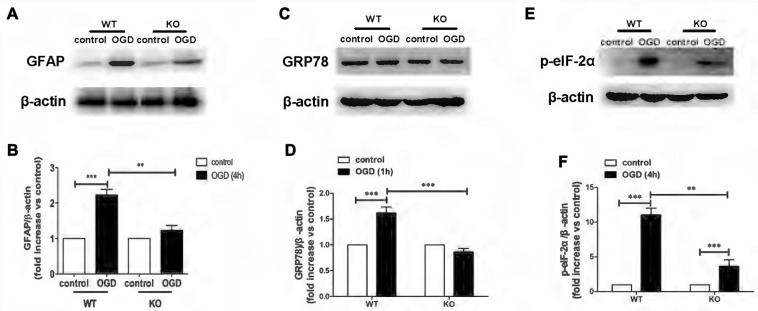
Genetic deletion of KCa3.1 attenuated OGD-induced ER stress in primary astrocytes. (A,B) Whole-cell lysates were collected to evaluate the expression of GFAP in wildtype (WT) and KCa3.1 KO astrocytes by western blotting after 4 h OGD. β-Actin was used as a loading control. The bar graphs represent the ratio of GFAP/β-actin, normalized to the control (n = 3–4). (C,D) Whole-cell lysates were collected to evaluate the expression of GRP78 in WT and KCa3.1 KO astrocytes by western blotting after 1 h OGD. β-Actin was used as a loading control. The bar graphs represent the ratio of GRP78/β-actin, normalized to the control (n = 3–4). (E,F) Whole-cell lysates were collected to evaluate the expression of p-eIF-2α in WT and KCa3.1 KO astrocytes by western blotting after 4 h OGD. β-Actin was used as a loading control. The bar graphs represent the ratio of p-eIF-2α/β-actin, normalized to the control (n = 3–4). The data are expressed as means ± SEM. **p < 0.01, ***p < 0.001. WT, wild type; KO, knockout; OGD, oxygen–glucose deprivation.